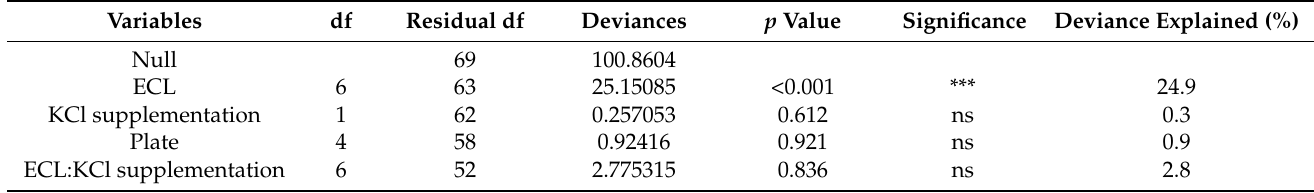
Table 8. Summary of deviances of the generalized linear model (GLM) of data from Table 7 (Effect of potassium chloride (KCl) supplementation on somatic embryo maturation efficiency of sugi embryogenic cell lines (ECLs)). Deviance of the variable “null” indicates the null deviance (deviance of the null model), and other deviances indicate the residual deviance (deviance of the